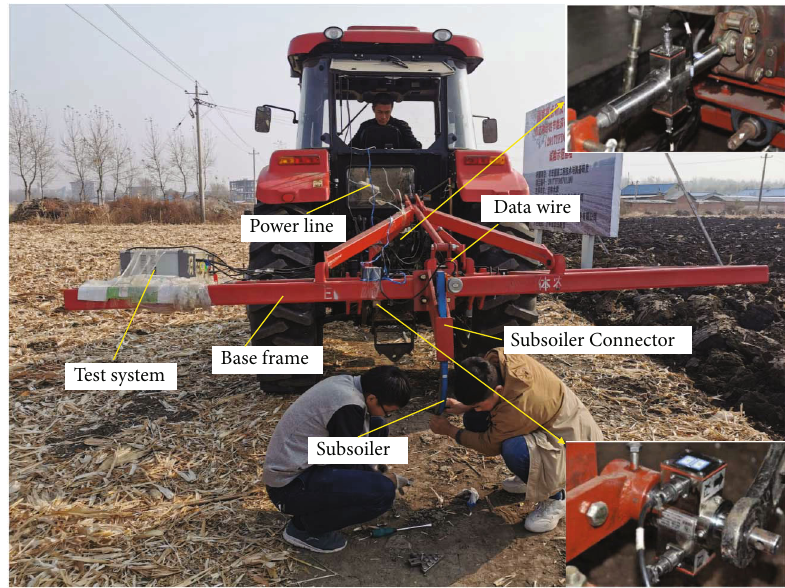
Figure 10: Subsoiling fi eld experiments.